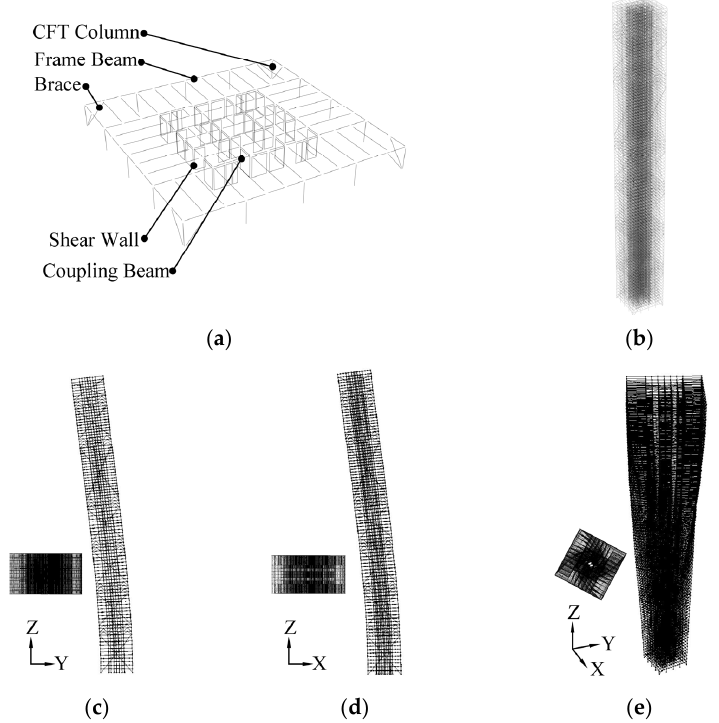
Figure 14. Schematic of the case-study building model: ( a ) view of the bottom story; ( b ) three- dimensional view, ( c ) deformation shape of mode 1, ( d ) deformation shape of mode 2, ( e ) deformation shape of mode 3.